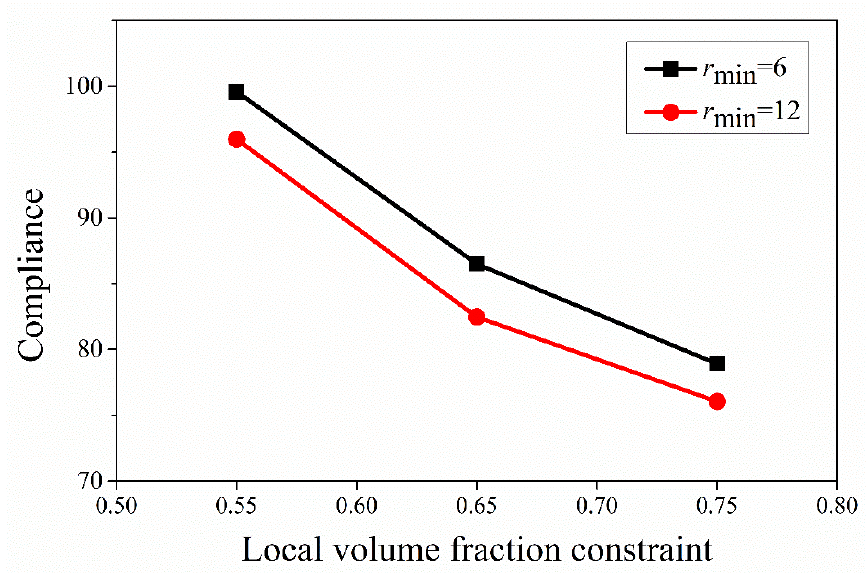
Figure 7. Relationship between c , r max and φ .